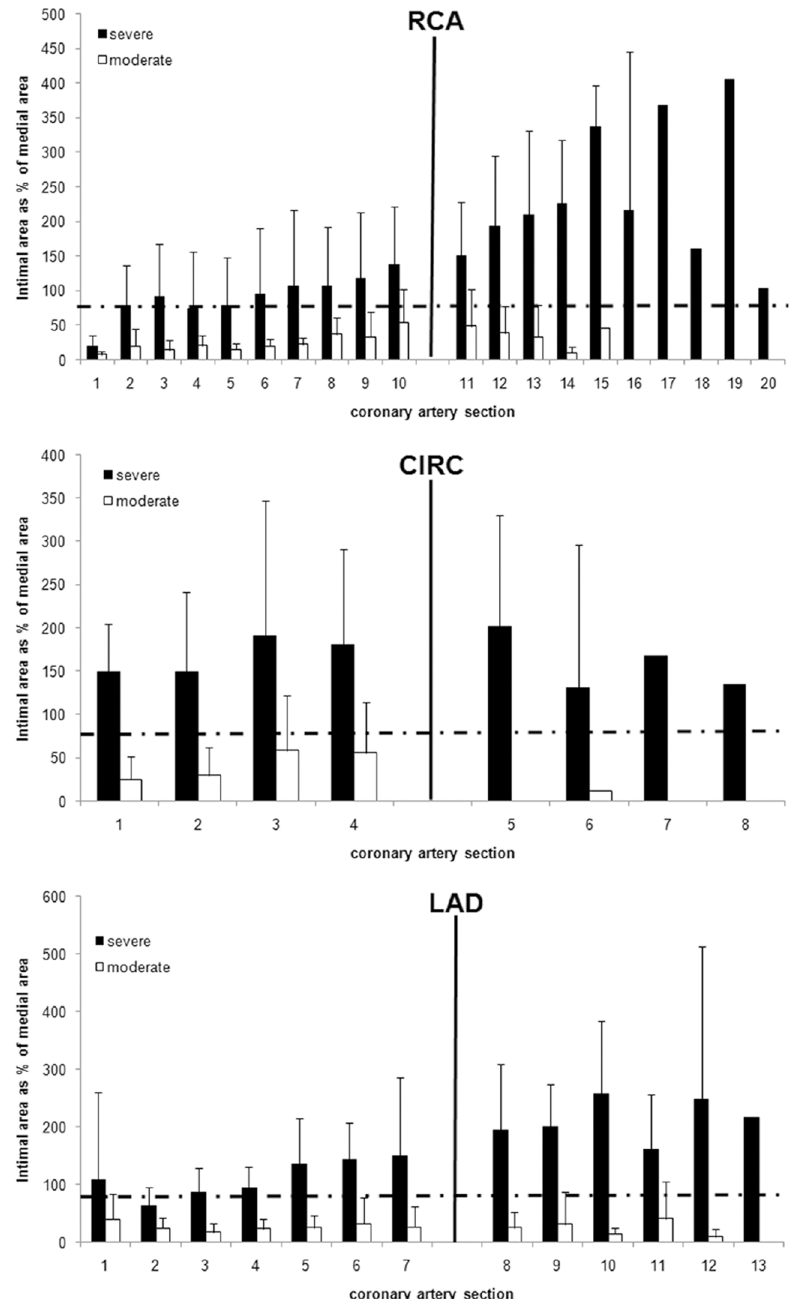
Fig 3. Intimal Area as % Medial Area from Serial Coronary Artery Sections. The mean ± SD for intimal area as % medial area of all sections from all three coronary arteries are shown by severe and diffuse (black), moderate (white), or control (grey) groups. Sections were taken at 1 cm intervals. The solid black vertical line indicates the division between the proximal and distal halves of each coronary artery. The horizontal black line at 200% indicates the criteria for severe coronary atherosclerosis. The hashed line at 150% indicates diffuse and distal coronary atherosclerosis when it occurs over 3 sections (i.e., 2 cm). Using these criteria, pigs in the severe atherosclerosis group also exhibited diffuse and distal coronary atherosclerosis in all three coronary arteries.